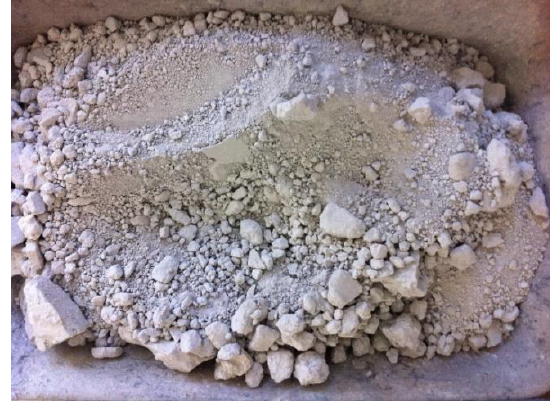
Figure 4. CSF as received (with 42% moisture content).